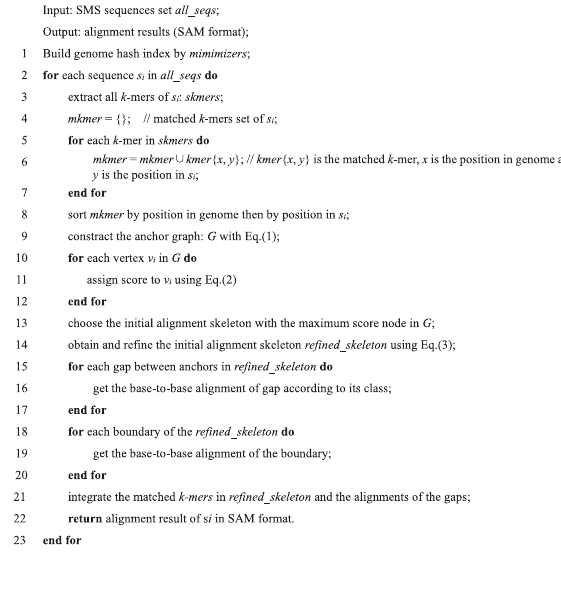
Algorithm 1. kngMap